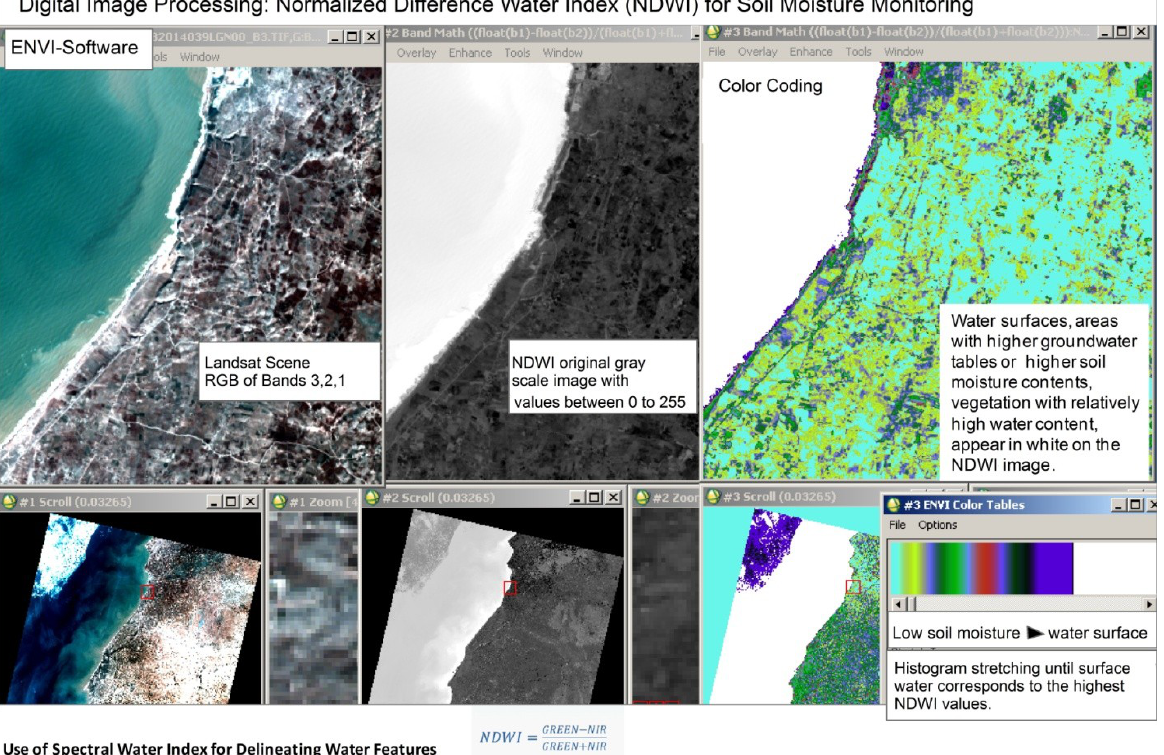
Figure 12. Extraction of higher Normalized Difference Water Index (NDWI) values.